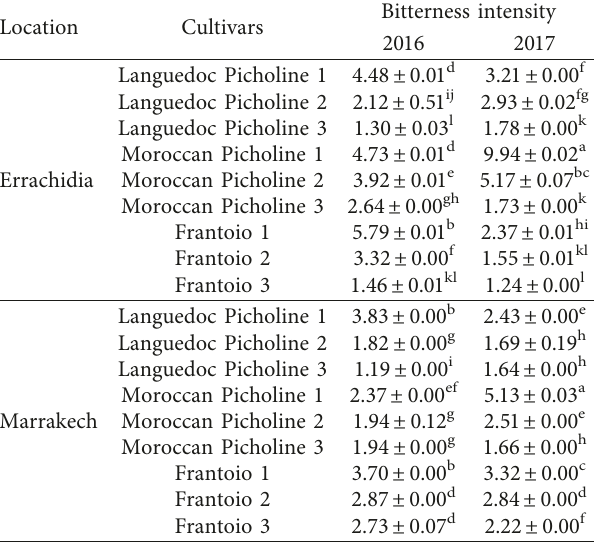
Values are means ± standard deviation (SD) of three replications. Data followed by different letters are significantly different from each other ( P < 0 . 05) according to LSD